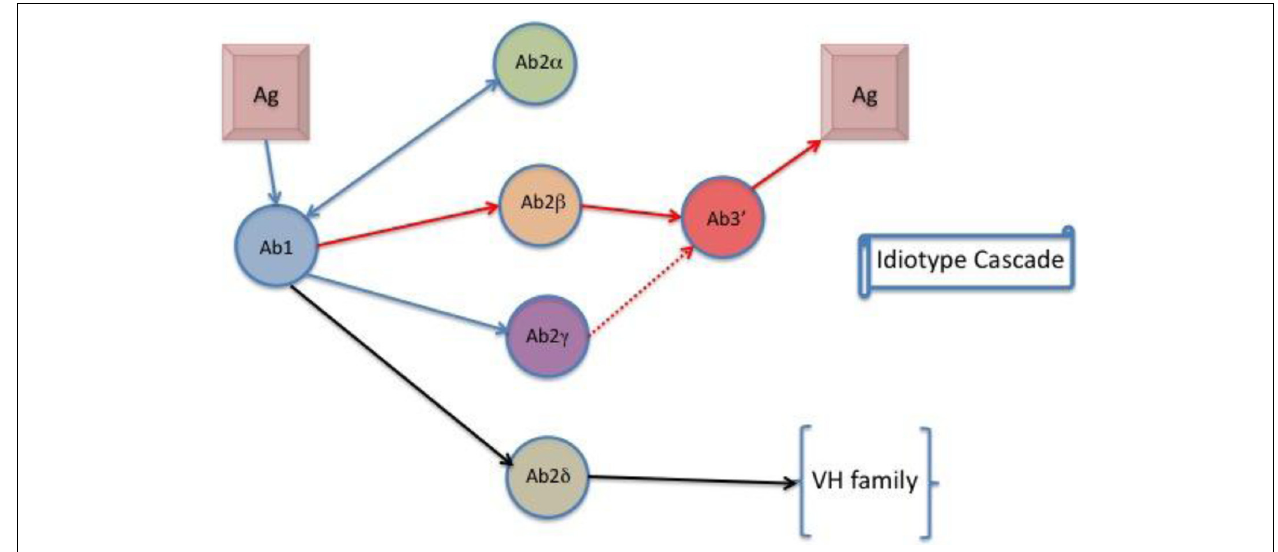
FIGURE 2 |The idiotype cascade. Ab1 binds to anti-idiotypic antibodies in ways associated with Ab2 properties. Ab2 δ is a new designation that defines binding to framework regions of Ab2 associated with the Ab2VH family.